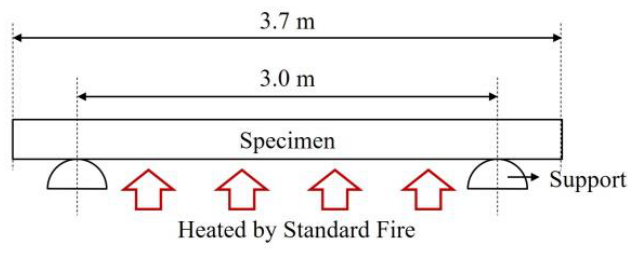
Figure 4. Floor specifications for fire tests based on previous version (2014) of Korean Standards [17,18].